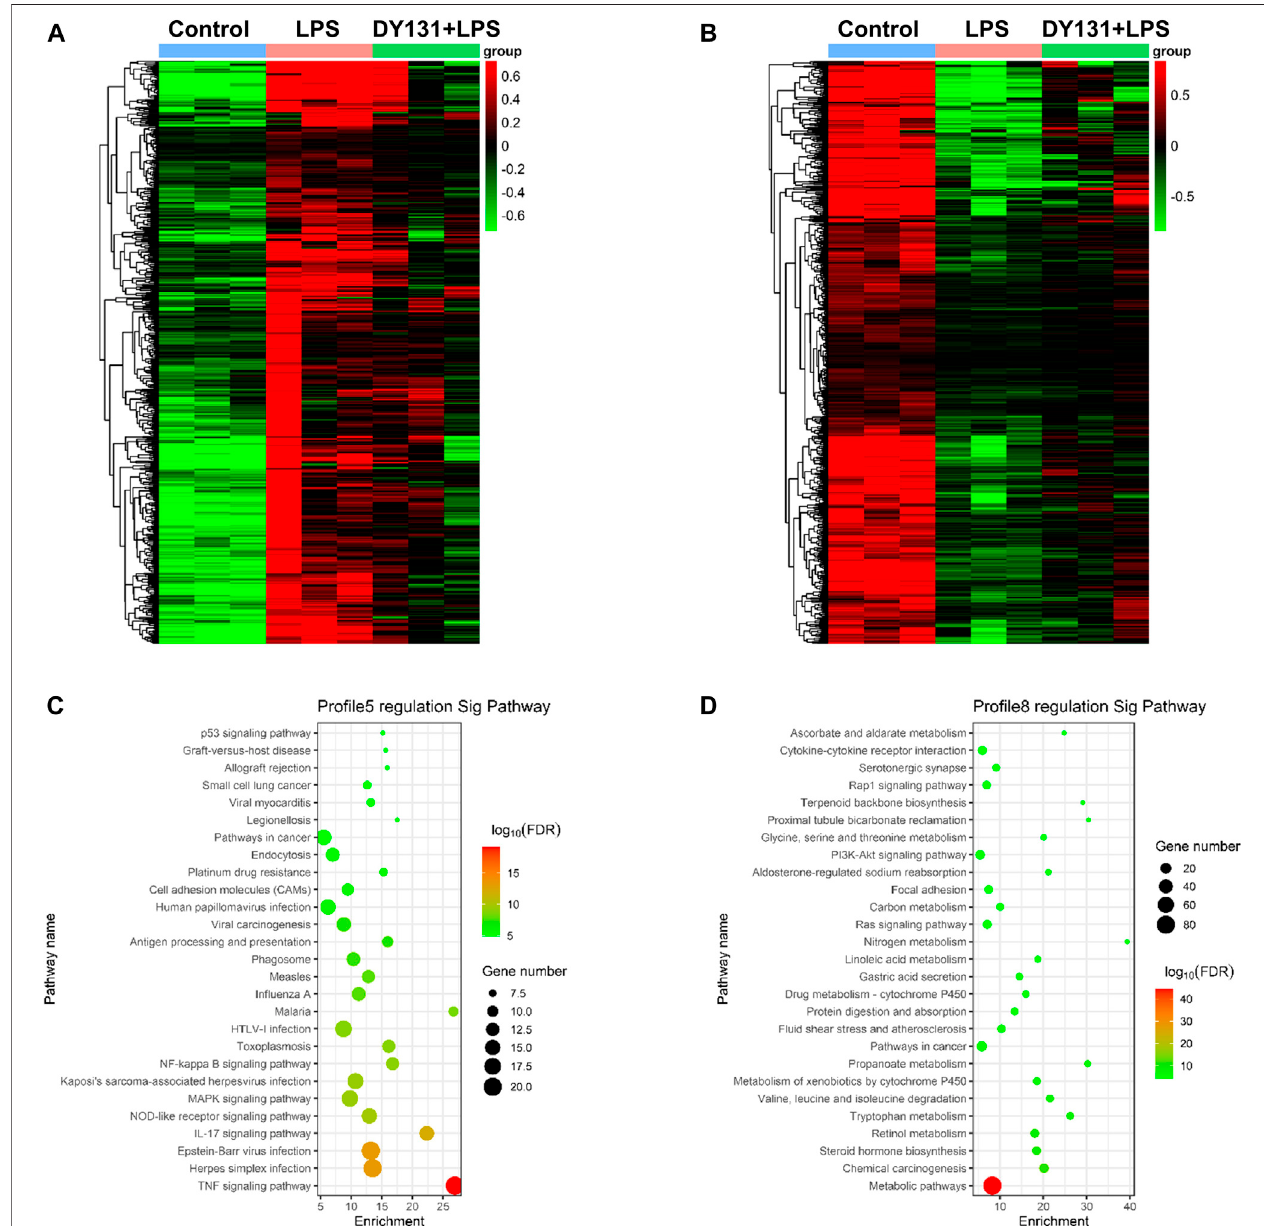
FIGURE7| Transcriptomicsanalysis. (A,B) HierarchicalclusteringanalysesofDEGsinPro fi le5 (A) andPro fi le8 (B) . (C,D) TheKEGGpathway analysisofDEGsin Pro fi le 5 and Pro fi le 8. Red and green dots indicate upregulated and downregulated transcripts, respectively. (E,F) Hierarchical clustering analyses of the top one signi fi cantly changed pathway in Pro fi le 5 (TNF signaling pathway) and Pro fi le 8 (metabolic pathway).